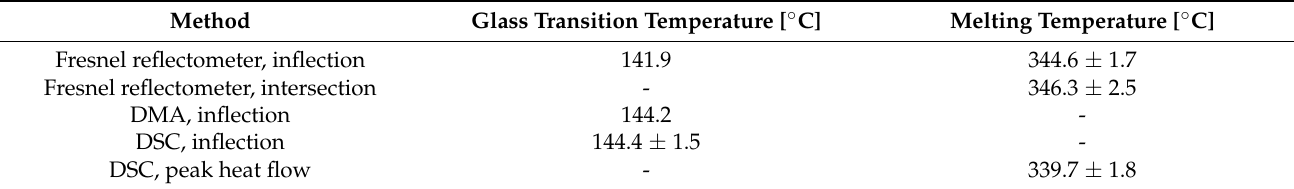
Table 3. Summary of the transition temperatures of PEEK.